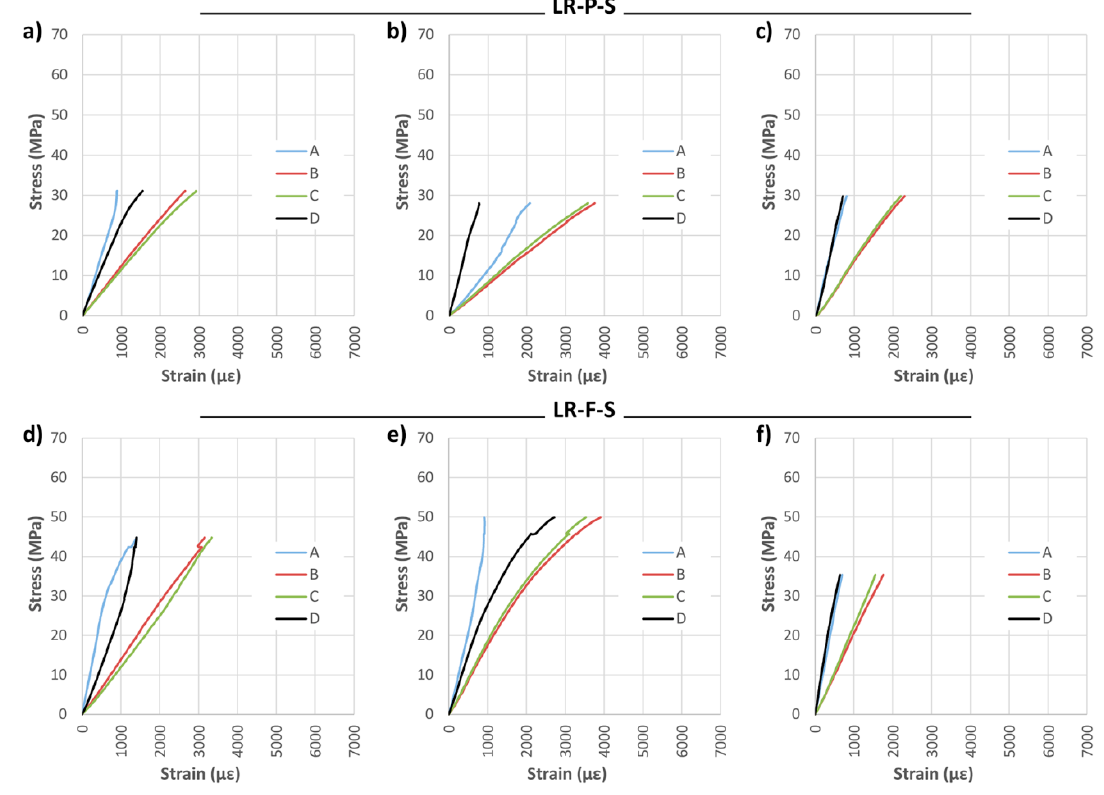
Figure 10. Stress against strain during bending tests: ( a ) LR-P-S-1; ( b ) LR-P-S-2; ( c ) LR-P-S-3; ( d ) LR-F-S-1; ( e ) LR-F-S-2; and ( f ) LR-F-S-3. CFRP supplier: SIKA ® .